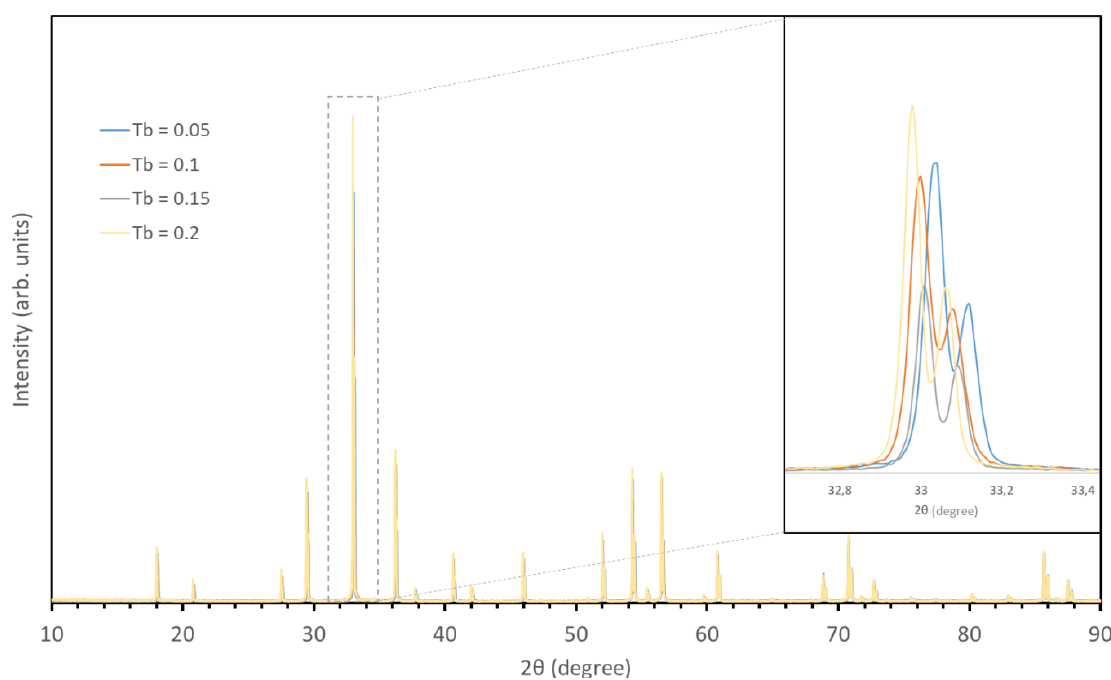
Figure 1. X-ray diffraction pattern of GYAGG:Tb ceramics samples with different terbium concen- tration.